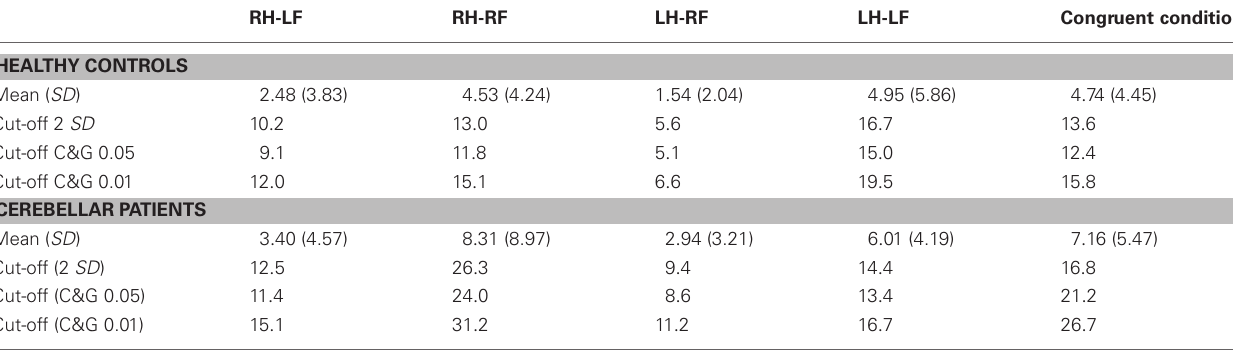
Table 3 | Cut-off scores.